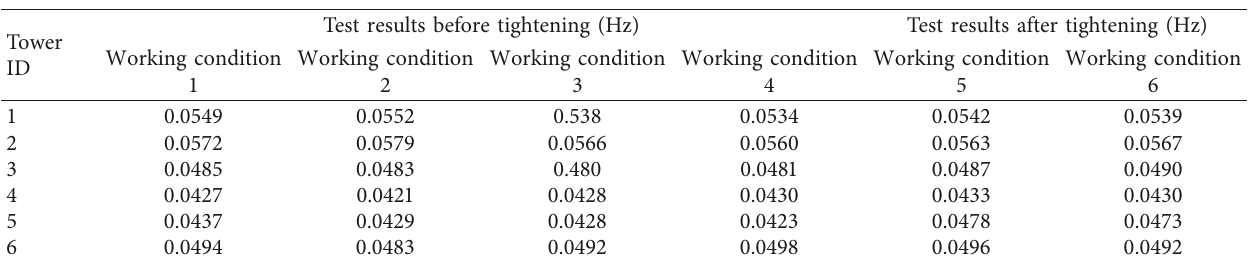
Table 5: Damping ratio of the first-order natural frequency of each wind turbine tower. Tower